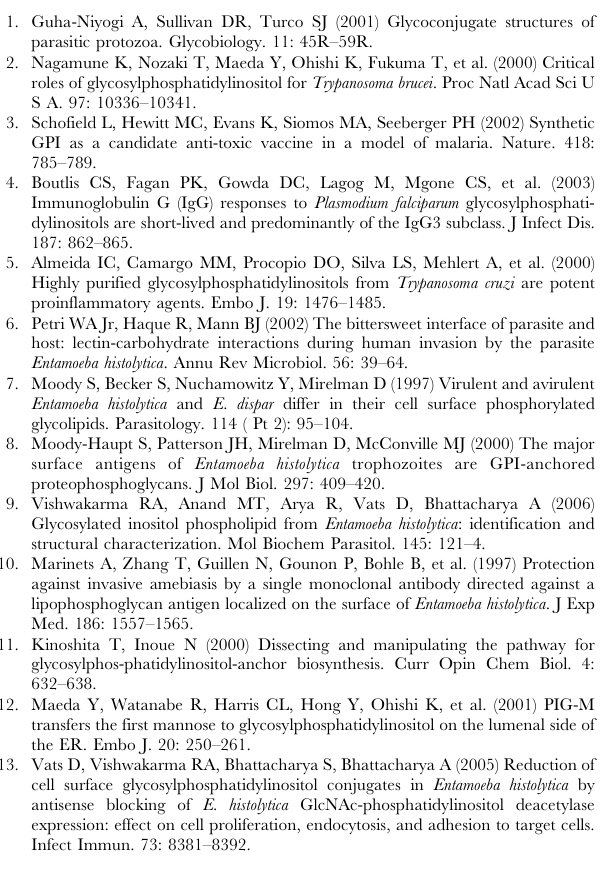
Figure S1. Amino acid sequence homology between